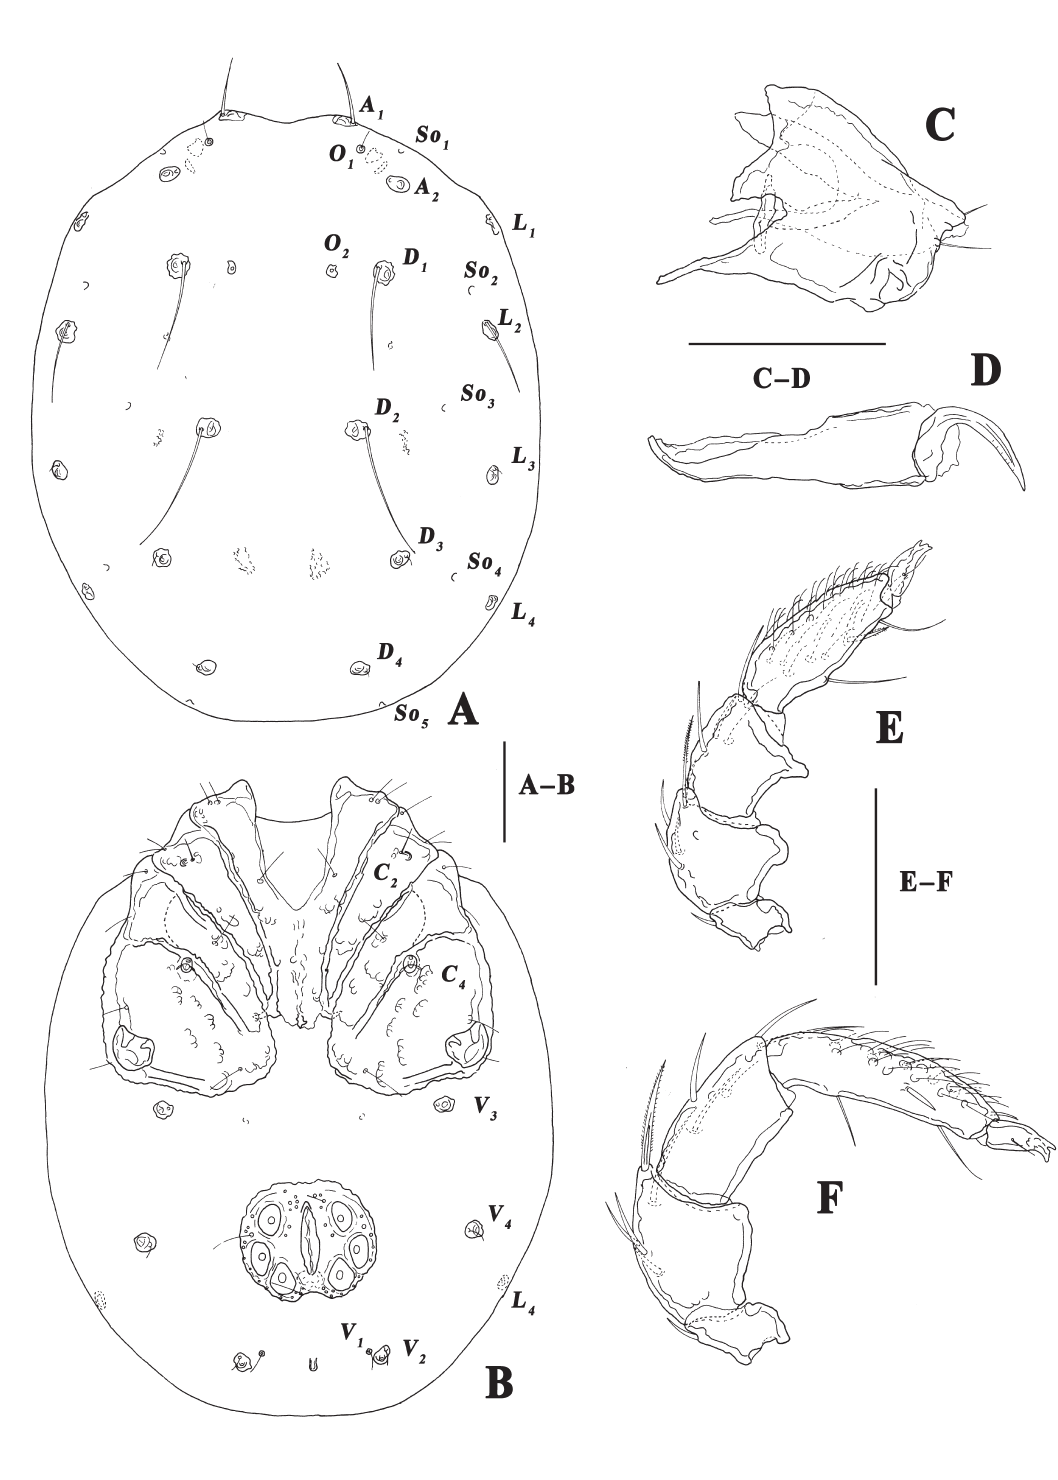
Fig. 1. Atractides ( Atractides ) biprojectus Zhang, Li & Guo sp. nov. A–E . Holotype, ♂ (GUGC, Slide No. QH-HY-2020071701). F . Paratype, ♀ (GUGC, Slide No. QH-HY-2020071705). A . Idiosoma, dorsal view. B . Idiosoma, ventral view. C . Gnathosoma. D . Chelicera. E . Palp. F . Palp. Scale bars = 100